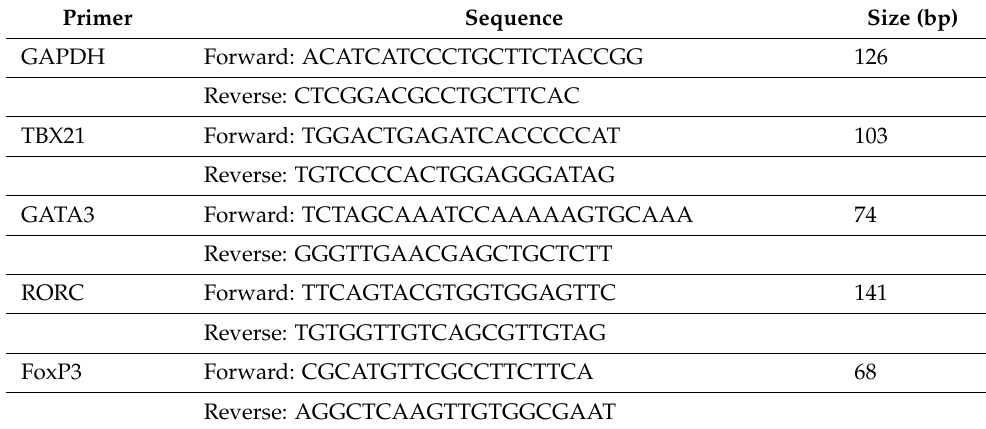
Table 2. Primer list in this